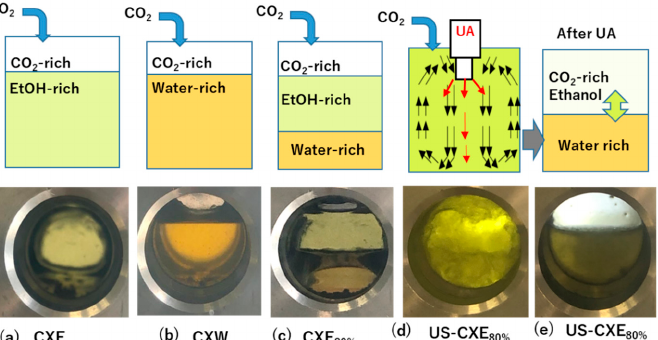
Figure 8. Phase behavior observed upon addition of CO 2 (25 °C 10 MPa) to different modifiers: ( a ) ethanol in CXE extraction system; ( b ) water in CXW extraction system; ( c ) 80% ethanol in CXE80% extraction system; ( d ) CXE80% extraction system during ultrasonication assistance (UA); ( e ) CXE80% extraction system after UA. Schematic diagrams above visual observations depict them as EtOH-rich or water- and CO 2 -rich conditions.